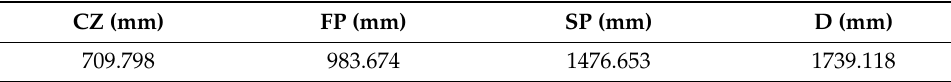
Table 1. Nest dimensions measured from the top down